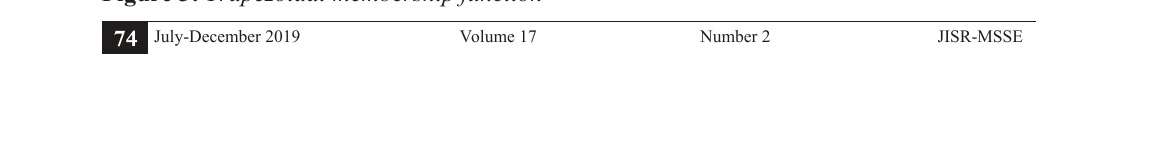
Figure 3: Trapezoidal membership